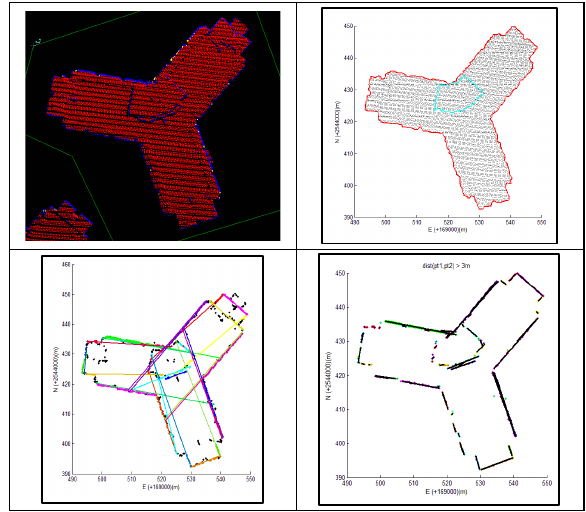
Figure 20. Test results of building